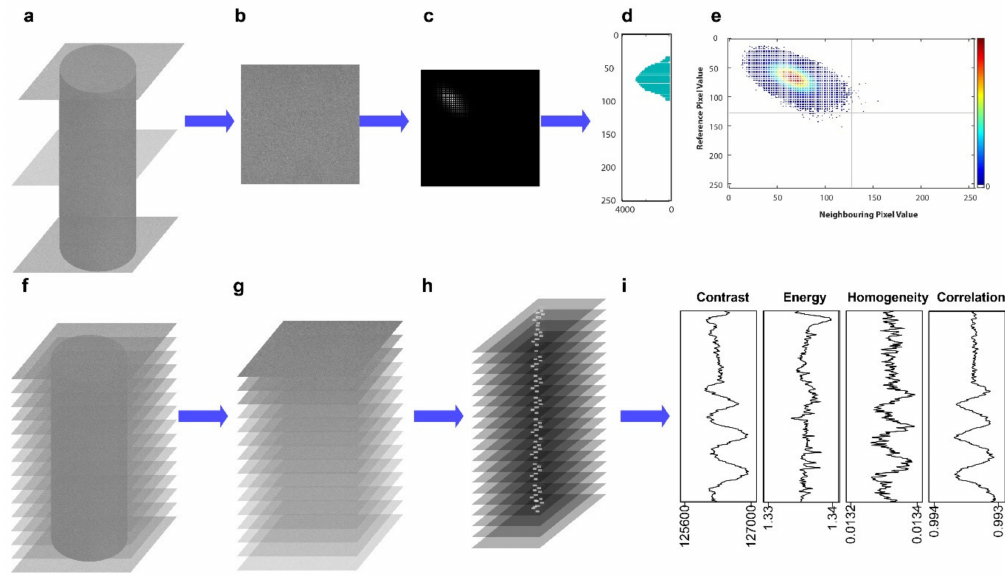
Figure 1. The 3D mineral texture quantification method using shale as an example; ( a ) 2D images within the 3D X-ray computed tomography (XCT) volume, ( b ) the gray level co-occurrence matrices (GLCM) are run on selected 2D image slices, which produces the 3D GLCM outputs; ( c ) matrices, ( d ) 3D GLCM histograms, ( e ) 3D GLCM heat maps, and ( i ) 3D GLCM statistics. The ( i ) statistical features, contrast, energy, homogeneity and correlation, can also be calculated for ( f , g ) the entire 3D volume and ( h ) its matrices stack